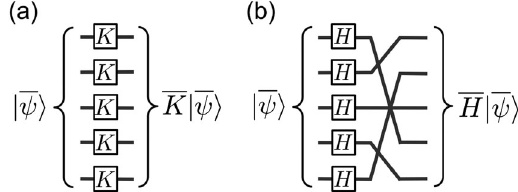
FIG. 2. Transversal implementations of (a) the octahedral gate K ¼ SH and (b) the Hadamard gate H on the 5-qubit